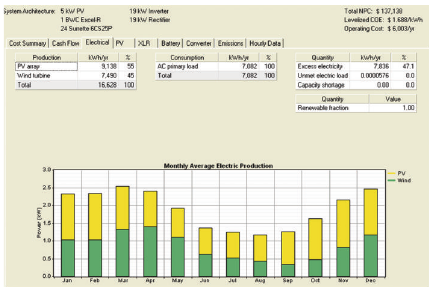
Figure 11: Electricity production summary of the integrated renew- able energy system.